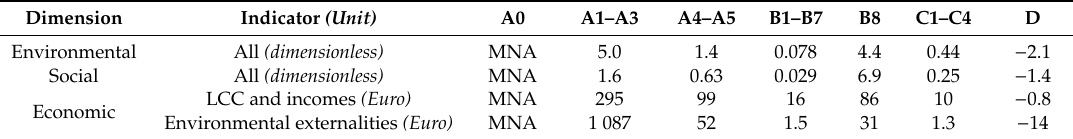
Table 6. Results for the SSC bridge design concept per life cycle stage and aggregated at the dimension level (or at the indicator level for the economic dimension) for the functional unit. The results for the environmental and social dimensions are normalized and weighted, and the results for the economic indicators are summarized. Modules not assessed are abbreviated as